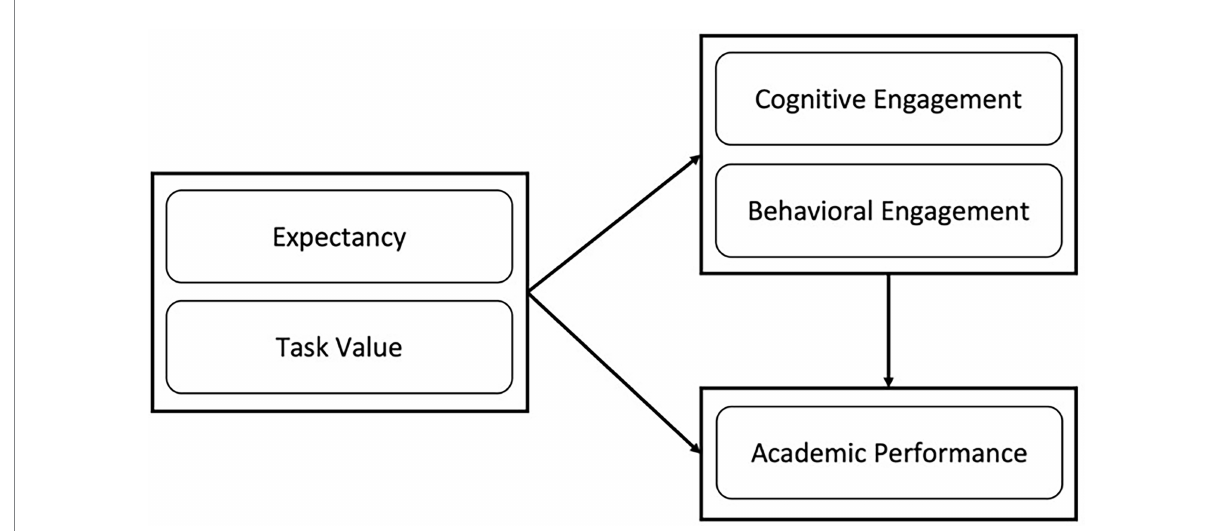
FIGURE 1 Conceptual model of relations between expectancy-value beliefs and academic performance mediated by